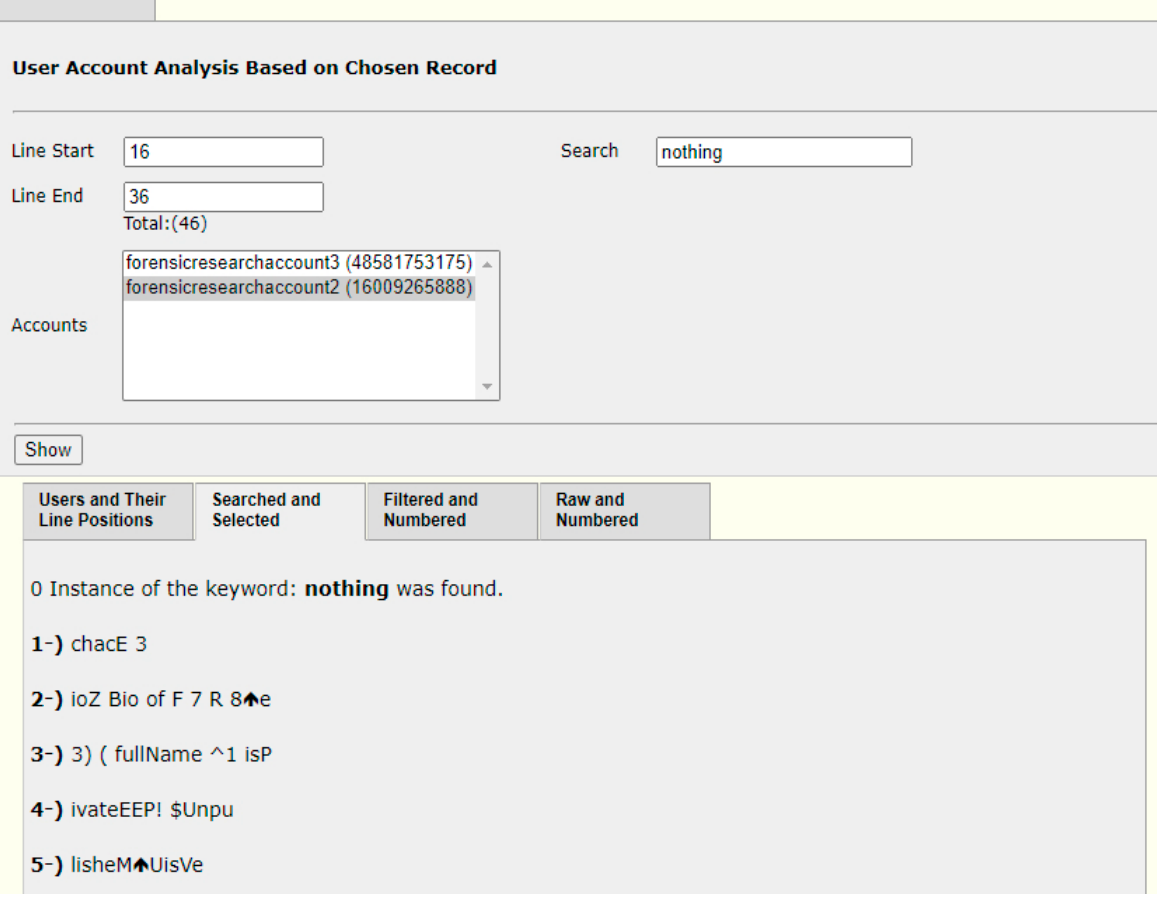
Figure 6. Searching Records for Non-existing Words.